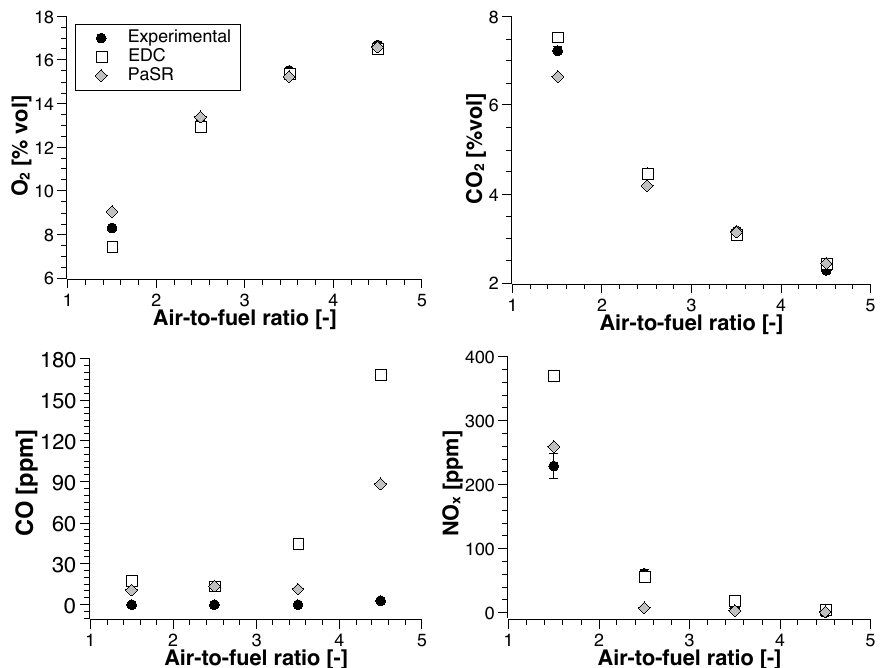
Figure 19. Comparison between measured values of O 2 (% vol), CO 2 (% vol), CO (ppm), and NO x (ppm) concentrations in the exhaust gas and those computed with EDC and PaSR combustion models for different air-to-fuel ratios. Air inlet temperature 730 ◦ . λ = 3.5. GRI3.0 kinetic